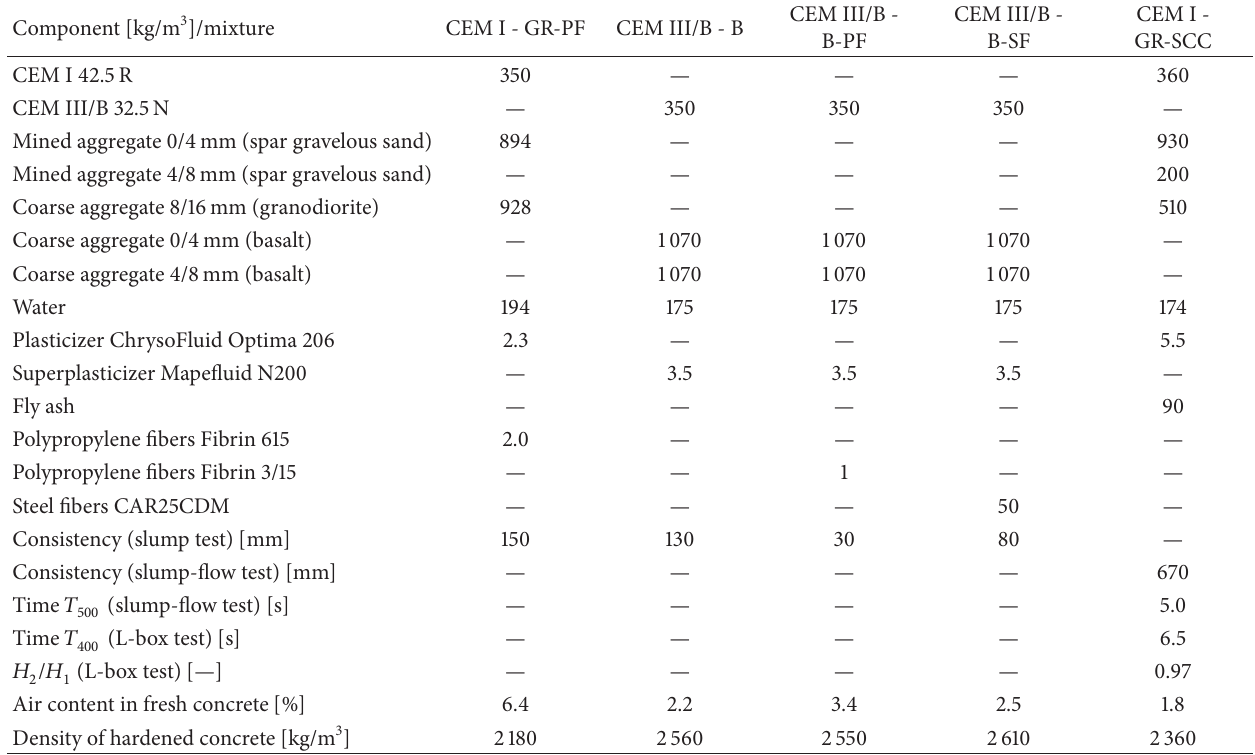
Density of hardened concrete [ kg/m 3